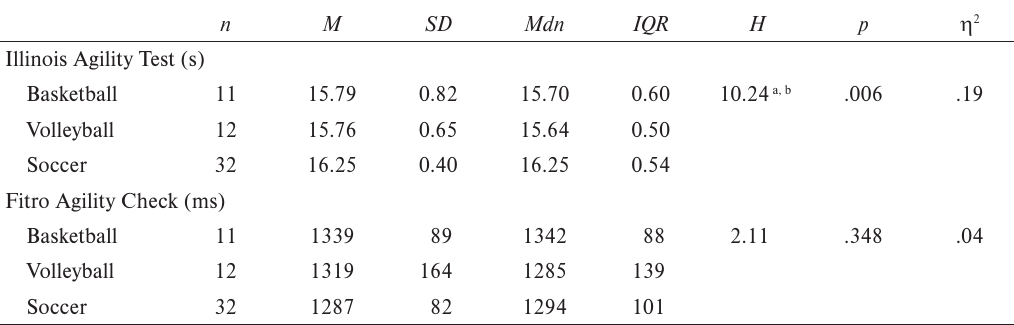
Descriptive statistics and inter-group differences in Illinois Agility Test and Fitro Agility